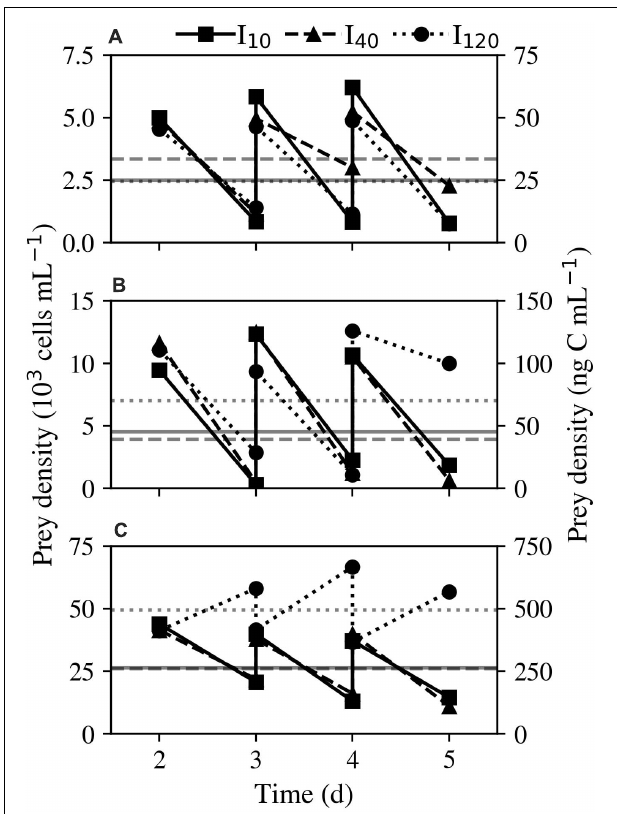
FIGURE 1 | Experiment 2: Acclimation of Strombidium cf. basimorphum to different prey densities: (A) 50, (B) 100, and (C) 400 ng C mL − 1 . Dilutions were made daily to return cultures to the experimental prey levels. Solid, dashed, and dotted lines denote light treatments I 10 , I 40 , and I 120 , respectively. Horizontal gray lines represent the average prey density of each culture over all sampling days. Data points are means ( n =